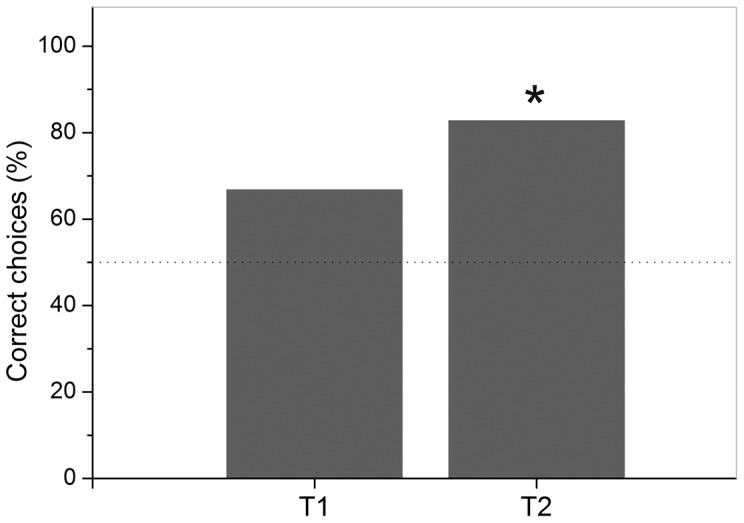
Transfer test results for Fish 5 in experiment 2b.Grey bars give the percentage of correct choices made by Fish 5 during the transfer tests T1 and T2. During each transfer, a total number of n = 12 transfer trials (no more than two per session) were inserted between the regular trials of each session in a randomized order. * =  significantly correct choices (p<0.05).